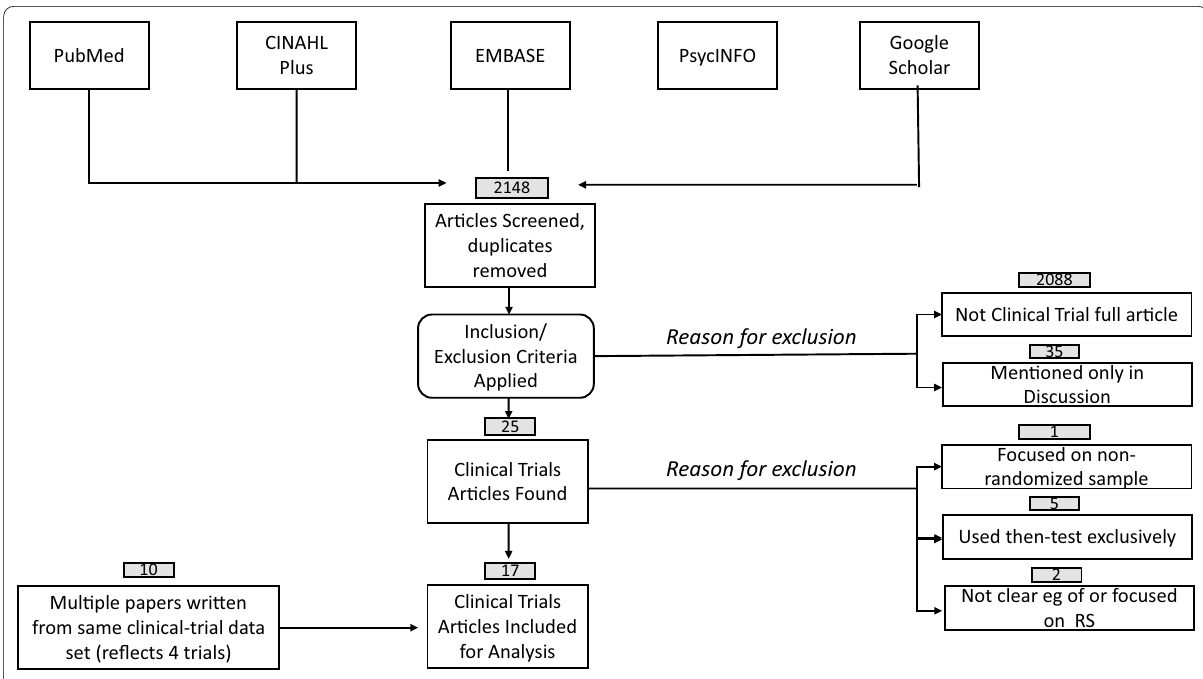
Fig. 1 Flow chart of the article selection process for final set of retained